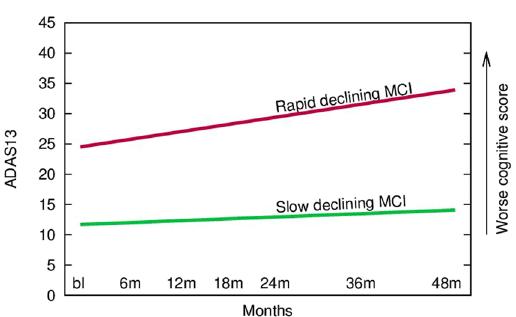
Figure 3. X-axis depicts duration of follow up. Y-axis depicts ADAS-Cog-13 total scores and higher scores depict greater worsening of cognition (due to more cognitive errors). The slopes depict the markedly different cognitive baseline and endpoint for slow versus rapid declining subpopulations of MCI